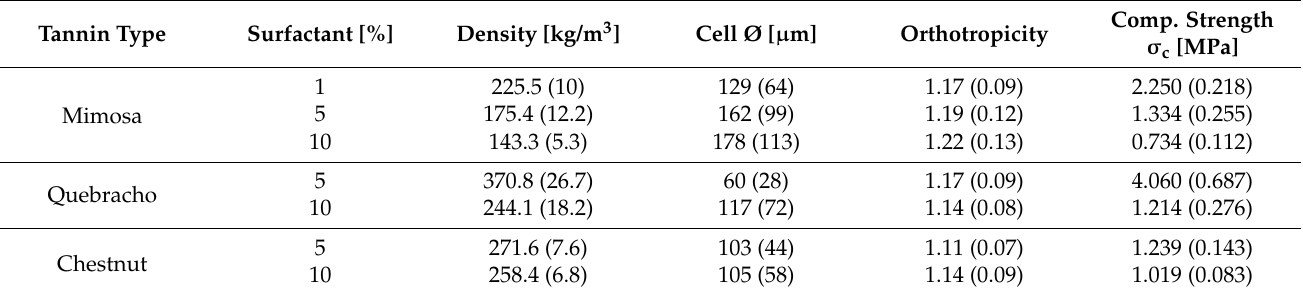
Table 1. Summary of main physical properties-standard deviation in